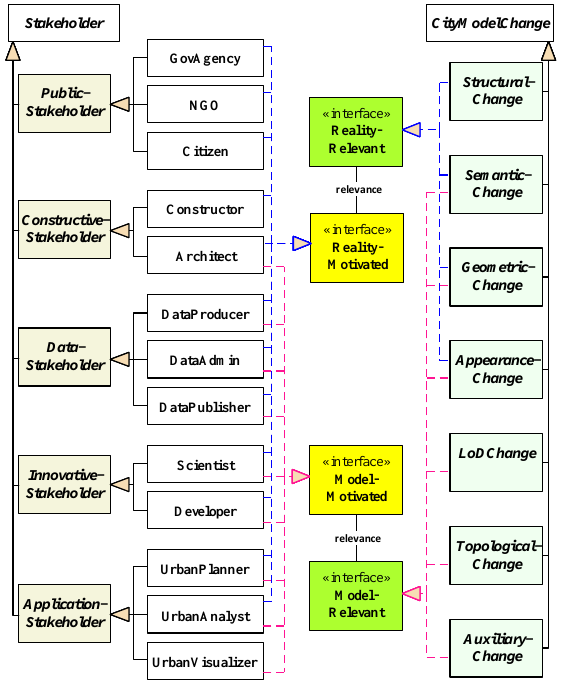
Figure 6. An example of a UML class diagram of stakeholders and their relations to changes in semantic 3D city models.